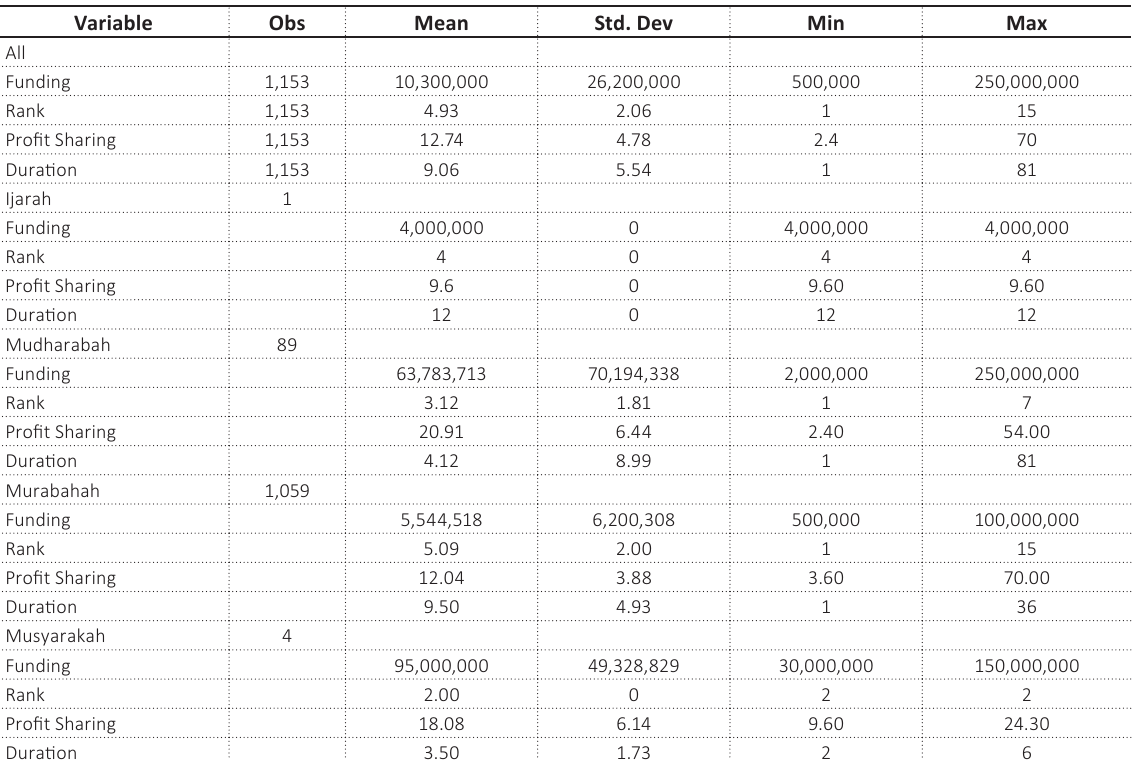
Table 1. Descriptive